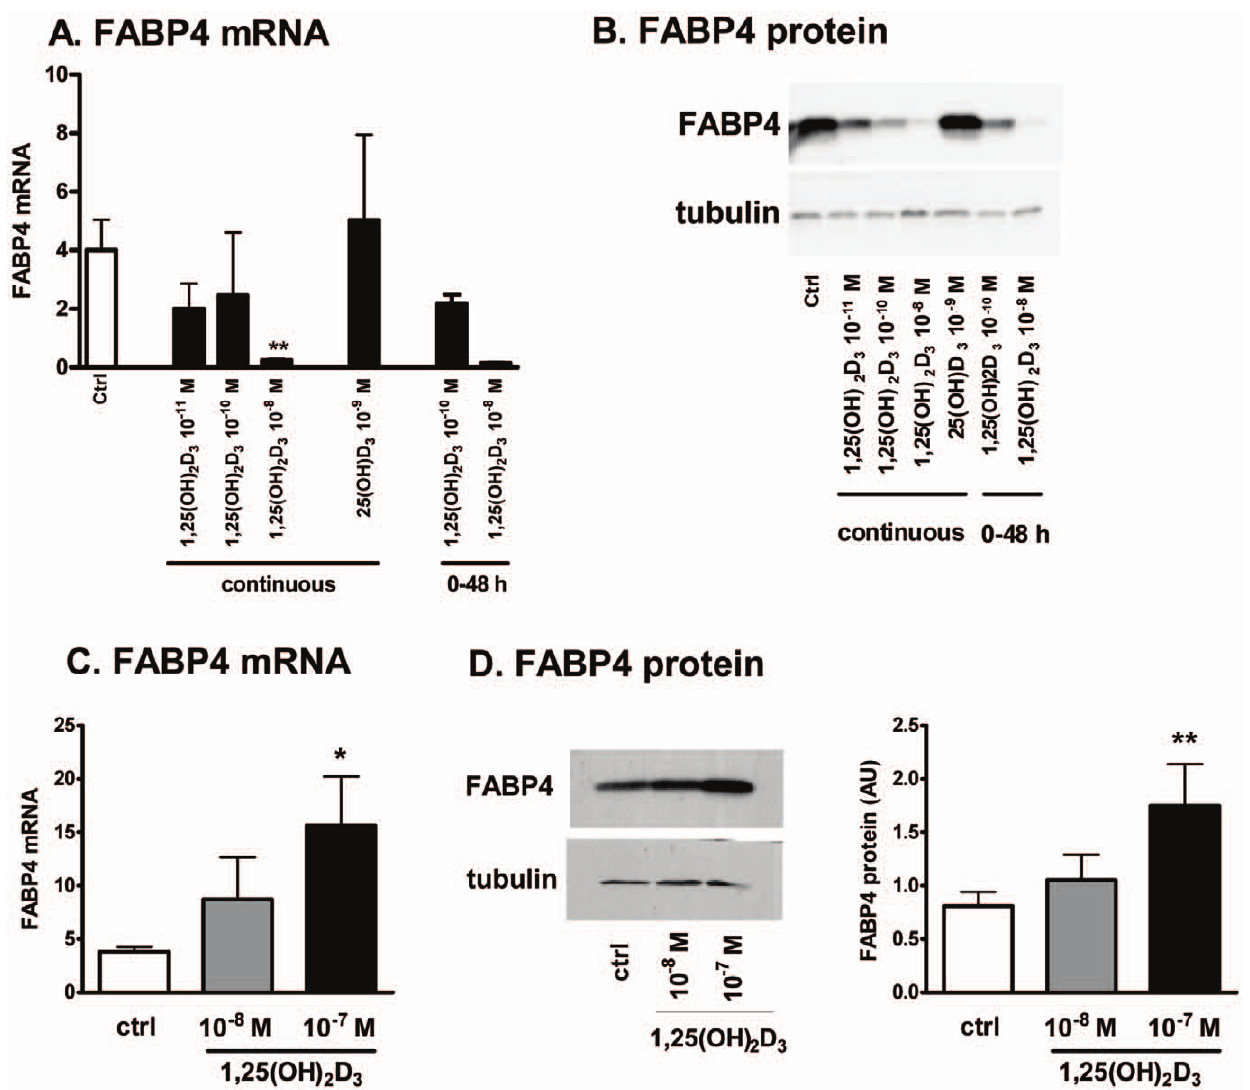
Figure 7. Effects of 1,25(OH) 2 D 3 on differentiation of 3T3-L1 preadipocytes (A & B) and mouse preadipocytes (C & D). A&B. 3T3-L1 cells were grown and differentiated using a standard protocol. Vehicle control, 1,25(OH) 2 D 3 or 25(OH)D 3 was added at indicated doses or periods of differentiation. FABP4 expression levels were measured as a late marker of differentiation. **, p , 0.01, control vs. treatment, n=2–3. C& D. 2d-post confluent mouse preadipocytes were differentiated in the presence of thiazolidinedione (1 m M Rosiglitazone during 2d-induction period). 1,25(OH) 2 D 3 (10 2 8 , 10 2 7 M) was added continuously and the degree of differentiation was determined by measuring FABP4 expression levels after differentiation. *, p , 0.05, vehicle control vs. treatment,